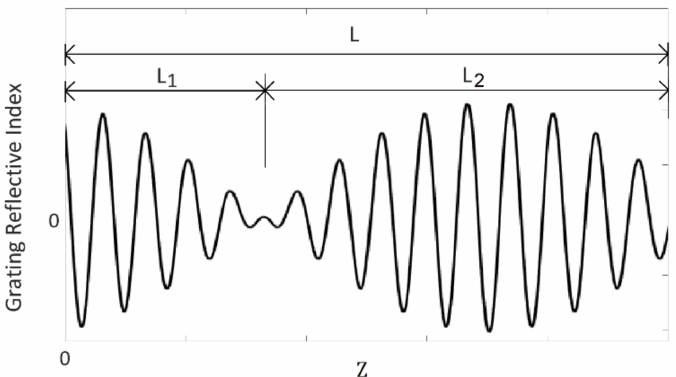
Figure 3. Refractive index modulation of AMFG generated by superimposing two gratings with slightly different periods, Λ 1 and Λ 2